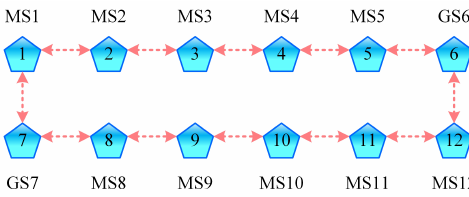
Figure 16. Communication graph for the large microgrid.